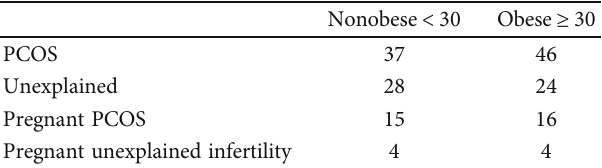
Table 3: Pregnancy in PCOS and unexplained